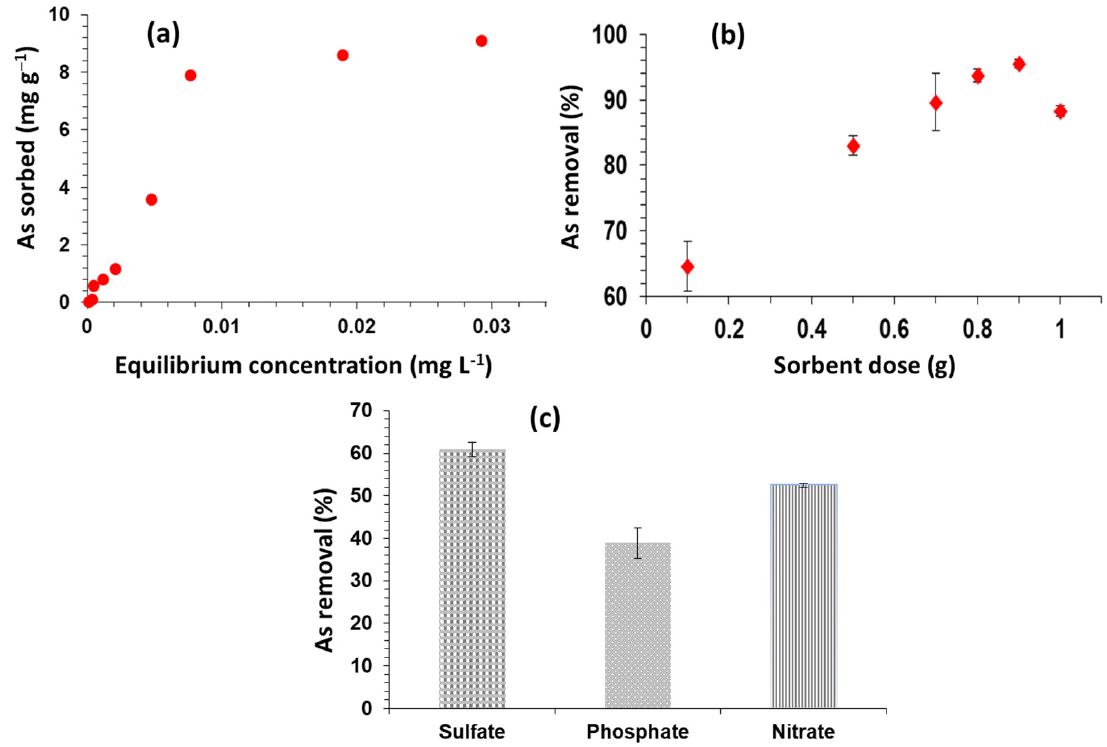
Figure 3. As(V) adsorption as a function of initial concentration ( a ), sorbent dose ( b ) and effects of anions ( c ). Table 2. Equilibrium isotherm modeling data of As(V) adsorption on egg shell biochar. Isotherm Models